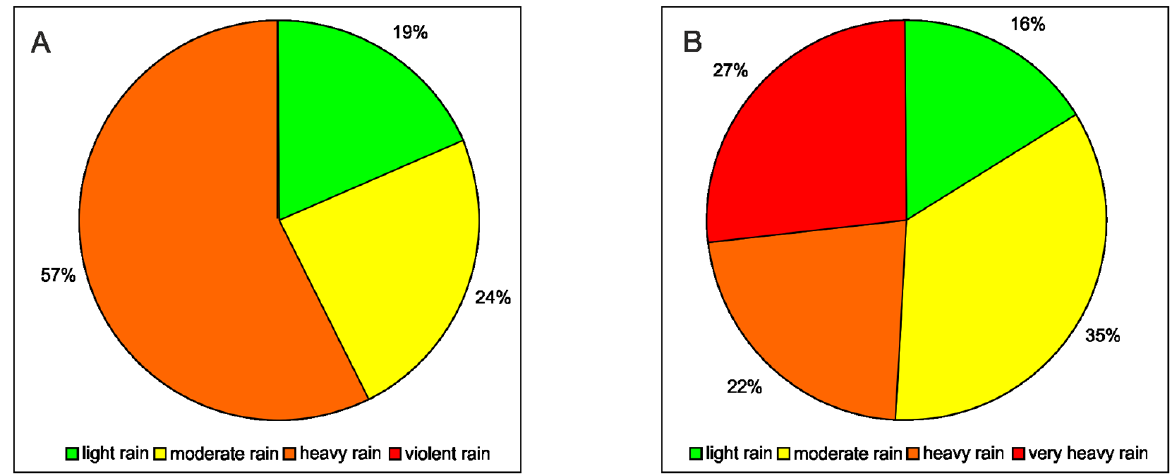
Figure 11. Daily rainfall classification of the counted flood events: A) from Glossary of Meteorology [2000]; B) from Bollettino di Vigilanza Meteorologica Nazionale of the Civil Protection National